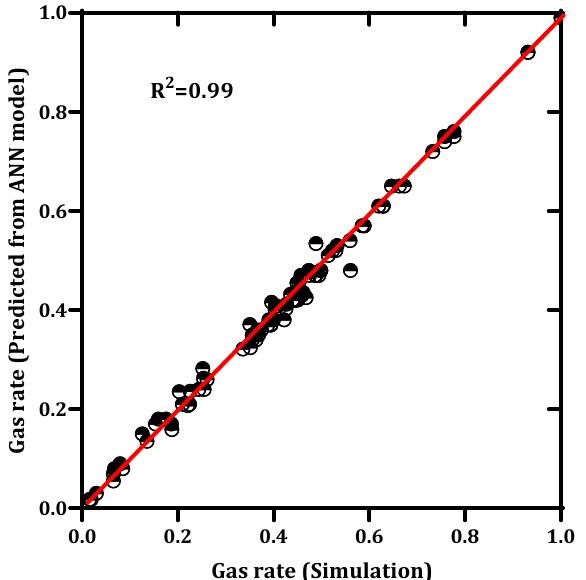
Figure 15. The predicted Qg from ANN versus simulation results for testing.